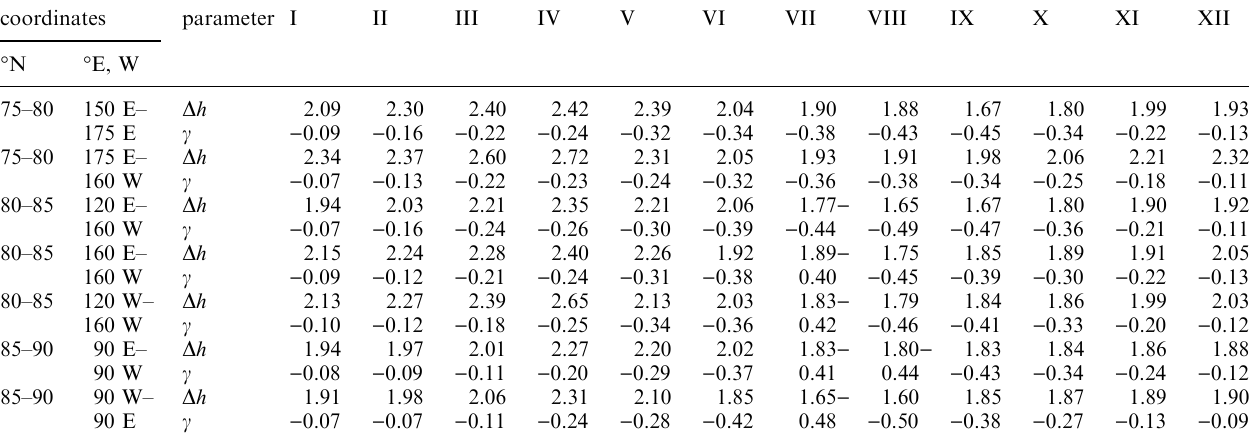
Table 2. Annual evolution of mean thickness ( (cid:68) h km) and vertical temperature gradient ( (cid:99) (cid:14) C/100 m) within tropopause layer coordinates parameter I